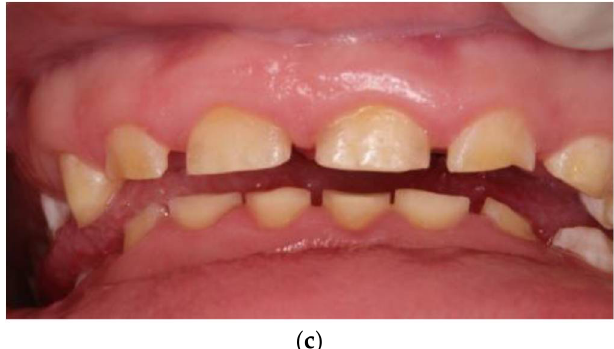
Figure 7. A 12-year-old patient showing clinical signs of AI type II: ( a , b ); upper teeth ( c ) front teeth. Besides the yellow color, gaps between teeth are predominant.